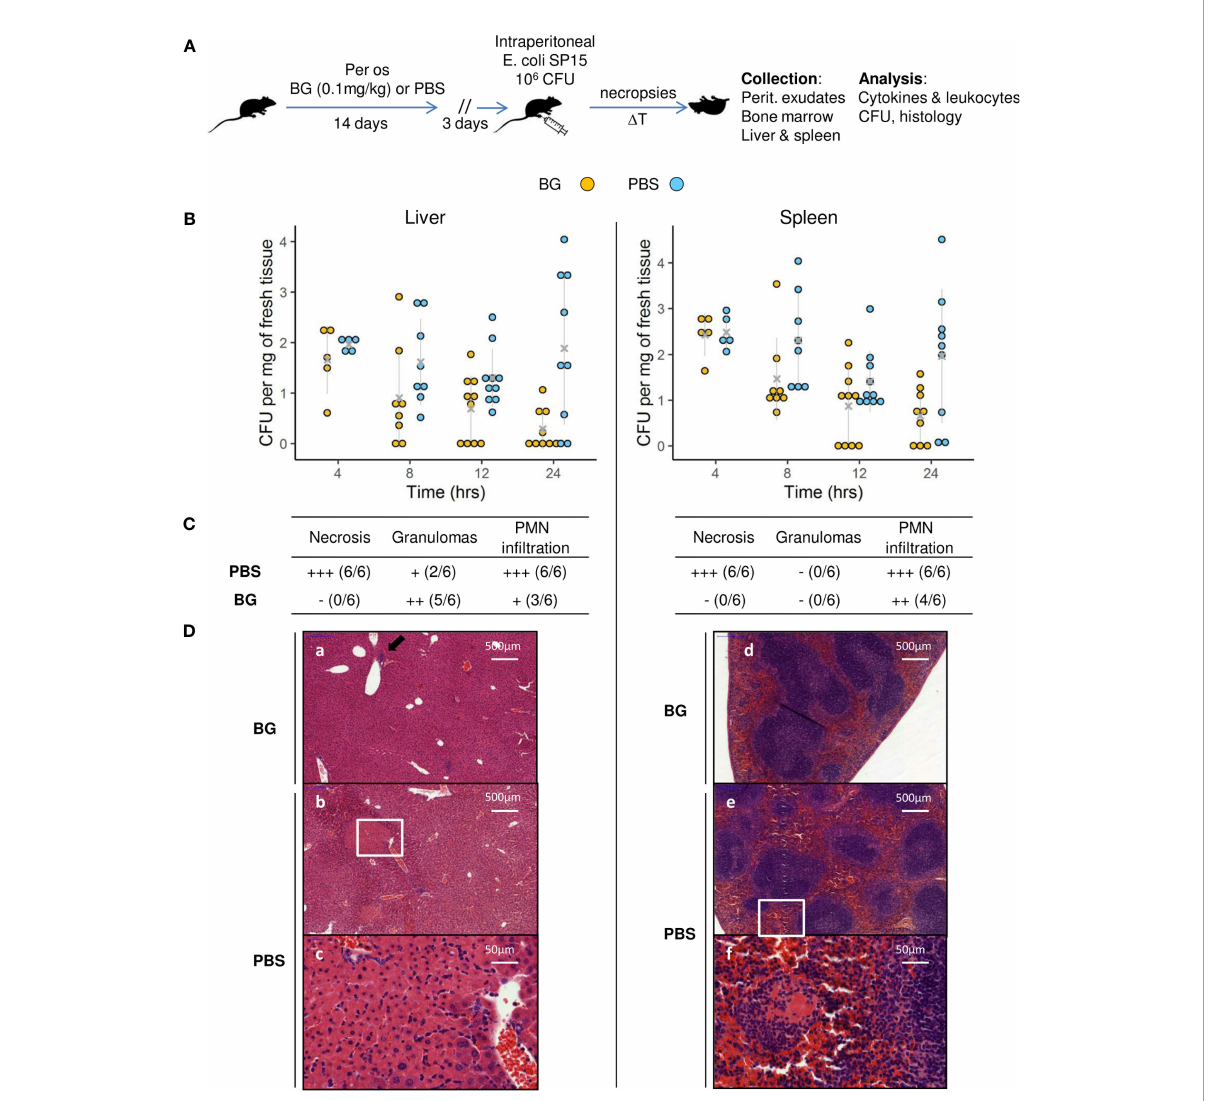
FIGURE 1 Bacterial fi tness and the host response in liver and spleen and histological examination after E . coli intra-peritoneal challenge of b -glucan or PBS orally-supplemented C57BL/6 mice. (A) Experimental design. (B) Bacterial loads in log CFUs per mg of fresh tissue in the liver and spleen over time. Grey crosses and bars represent the mean ± SD. Statistical analysis was performed using the Welch t-test and signi fi cant p values are indicated. (C) Histological examination of hematoxylin eosin-stained sections of liver and spleen sampled at 24 h p.i. Magni fi ed areas are indicated by white delimitations. (D) Results of the semi-quantitative grading of histological features ( – ) absent, (+) minimal, (++) moderate, and (+++) severe and the number of mice from each group presenting these features. The number of mice used and experiments are detailed in Supplementary Table